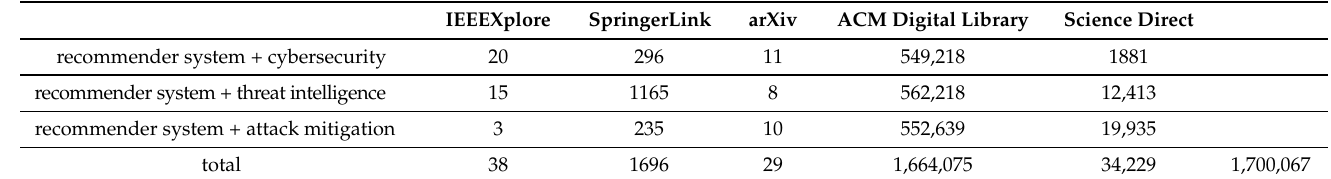
Table 1. Search engine hit